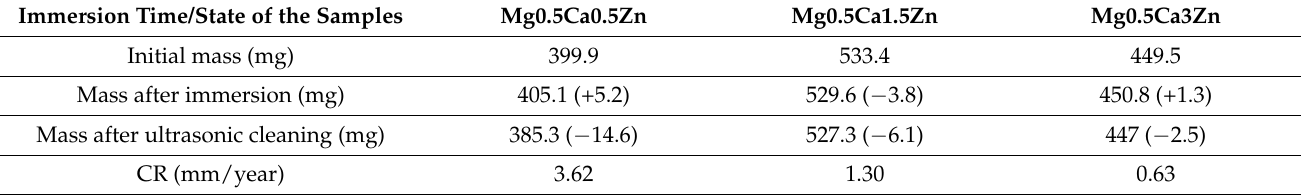
Table 4. Corrosion rate determined by each mass loss of samples subjected to immersion tests and subsequent cleaning in an ultrasonic bath (Immersion time for 5 days).